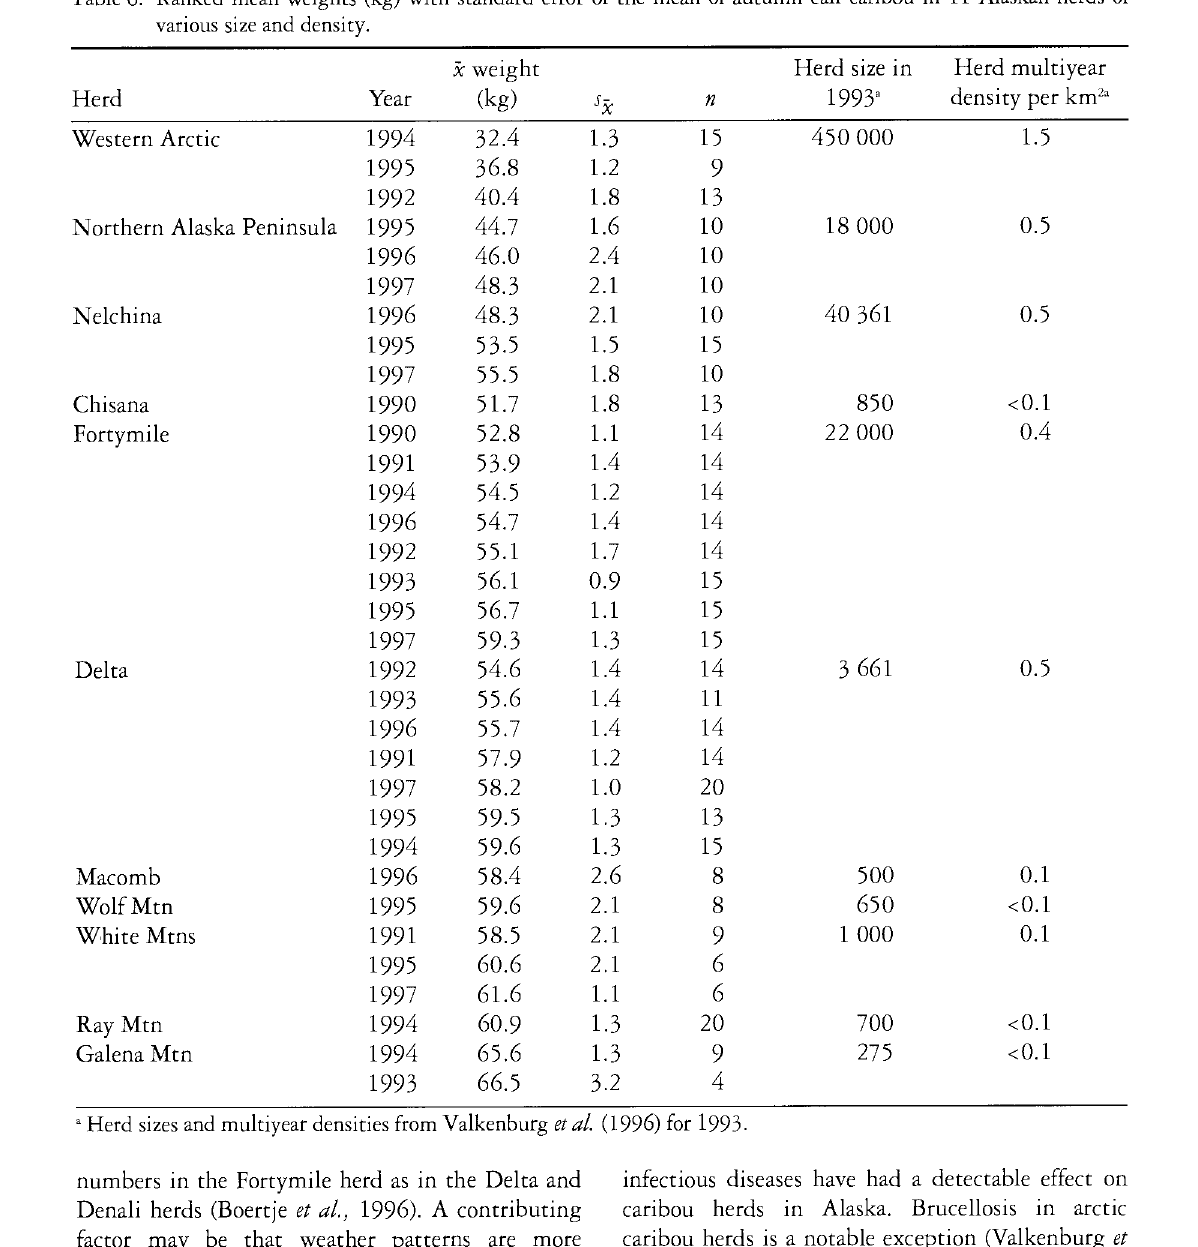
Table 6. Ranked mean weights (kg) with standard error of the mean of autumn calf caribou in 11 Alaskan herds of various size and density. x weight Herd size in Herd multiyear Herd Western